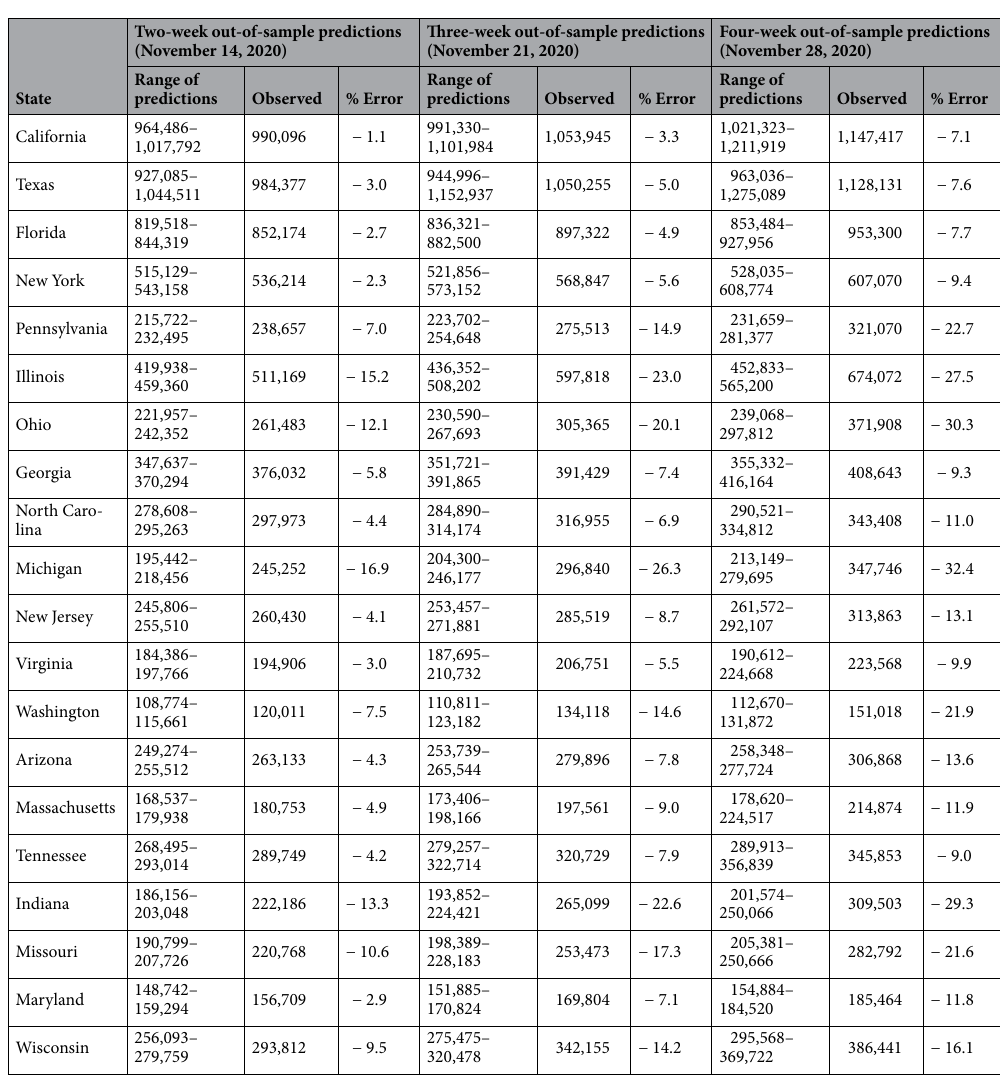
Table 4. Model performance for two-, three-, and four-week out-of-sample predictions of the cumulative COVID-19 cases in the top 20 populous